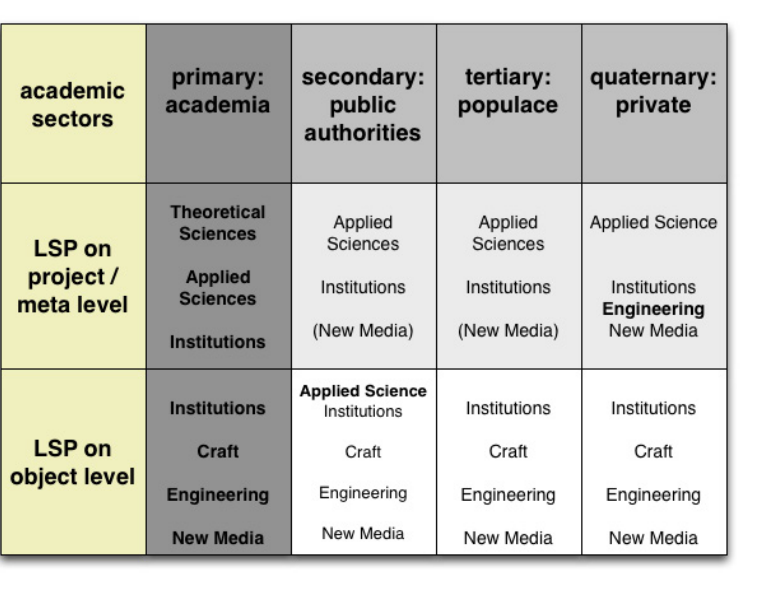
Fig.5: horizontal structuring based on academic sectors as applied to communication within a research